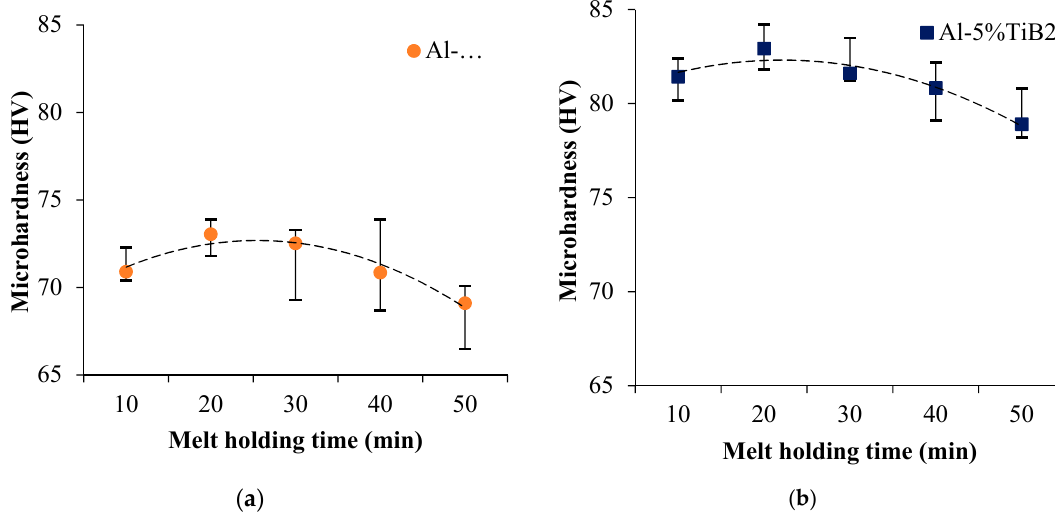
Figure 7. Microhardness variation with holding time for ( a ) Al ‐ 2.5%TiB 2 and ( b ) Al ‐ 5%TiB 2 composite.